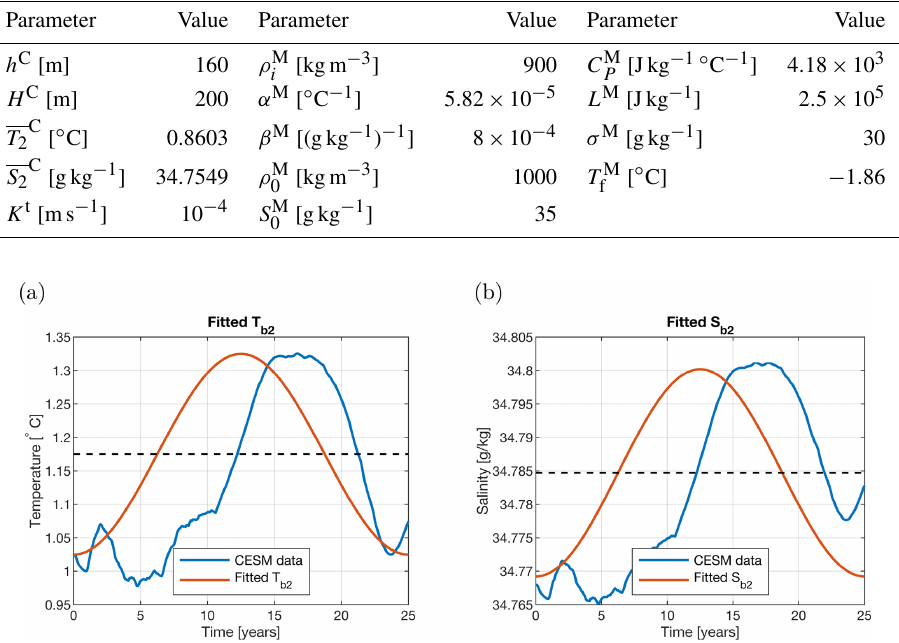
Figure 4. (a) Subsurface background temperature ( T b2 ) (red) used in the extended model setup fitted to model years 206–231 of the CESM simulation of van Westen and Dijkstra (2020a) (blue). The CESM simulation model output (blue line) is averaged over depth (200–1000m) and smoothed through a 5-year running mean. The black dashed line represents the time mean used in MKL and MKH. Panel (b) is the same as panel (a) but for the subsurface background salinity ( S b2 ). The CESM data are spatially averaged over the 11–12 ◦ E × 63.5–66.5 ◦ S region, which is upstream of the polynya region defined in van Westen and Dijkstra